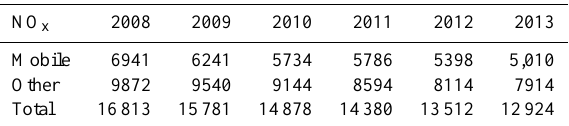
Table 1. EPA emission trends for NO x (values reported in thousands of tonnes.